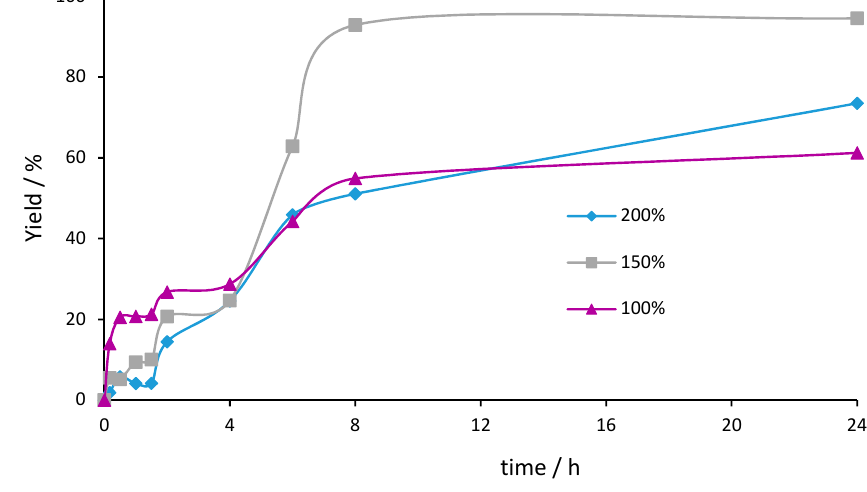
Figure 4. Kinetics with MoO 2 –Fe 2 O 3 with different added amounts of TBHP.